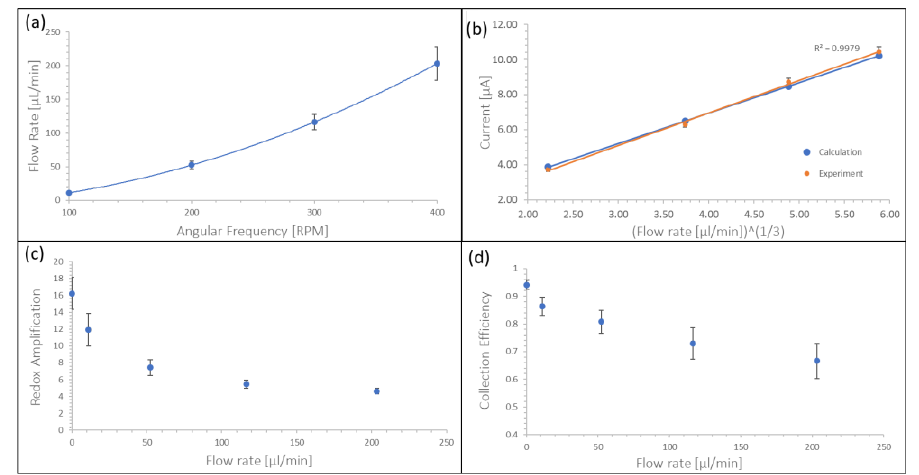
Figure 5. ( a ) Relation between angular frequency and flow rate, ( b ) Calculated (blue) and experimental Single Mode currents for increasing flow rate (platinum IDA) ( c ) Measured RA versus flow rate (Platinum IDA), ( d ) Measured CE versus flow rate (platinum IDA).